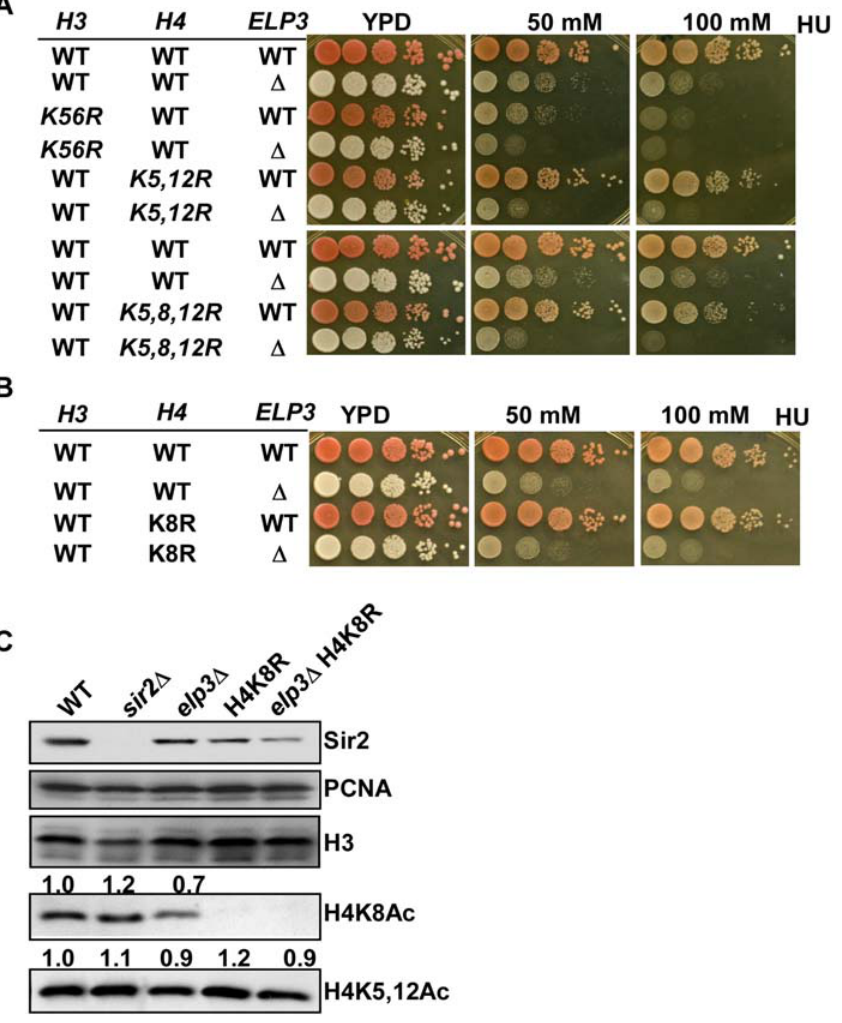
Figure 6. The elp3 D mutation genetically interacts with mutations on lysine residues of H3 and H4 that have been implicated in replication-coupled nucleosome assembly. (A) The elp3 D mutant cells are much more sensitive to HU when combined with lysine-to-arginine mutations at lysine 56 of H3 or at lysine residues 5, 8, and 12 of H4. The experiments were performed as described in Figure 5. Images for HU sensitivity were taken after incubation at 30 u C for four days. (B) The elp3 D mutant cells do not exhibit additional phenotype when combined with a lysine-to-arginine mutation at lysine 8 of H4. (C) The level of acetylation of H4 lysine 8 is reduced in the elp3 D mutant cells. Cell extracts were prepared from wild type and different mutant cells and analyzed by Western blot using antibodies against indicated proteins. The band intensity was quantified using Quantity One (Bio-Rad laboratories).